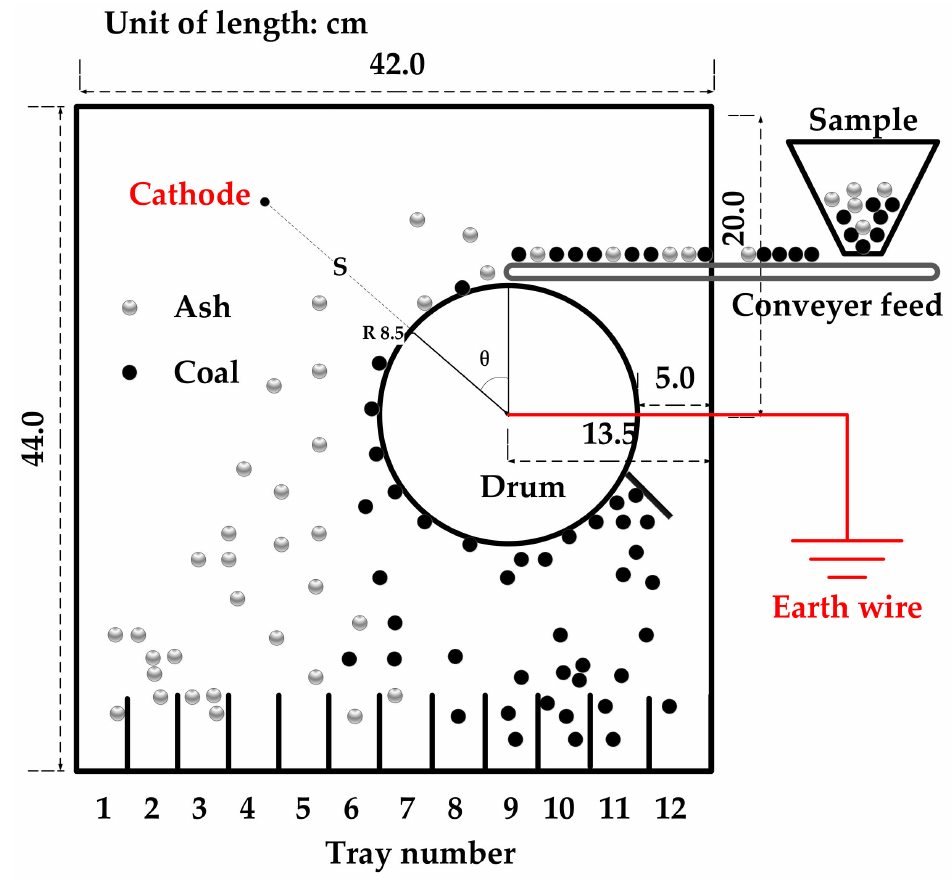
Figure 1. Main components of the originally developed experimental